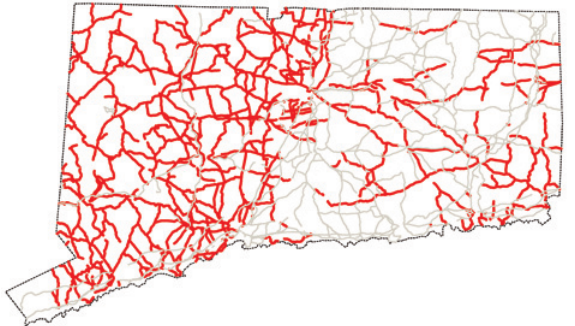
Fig. 4. Network dataset